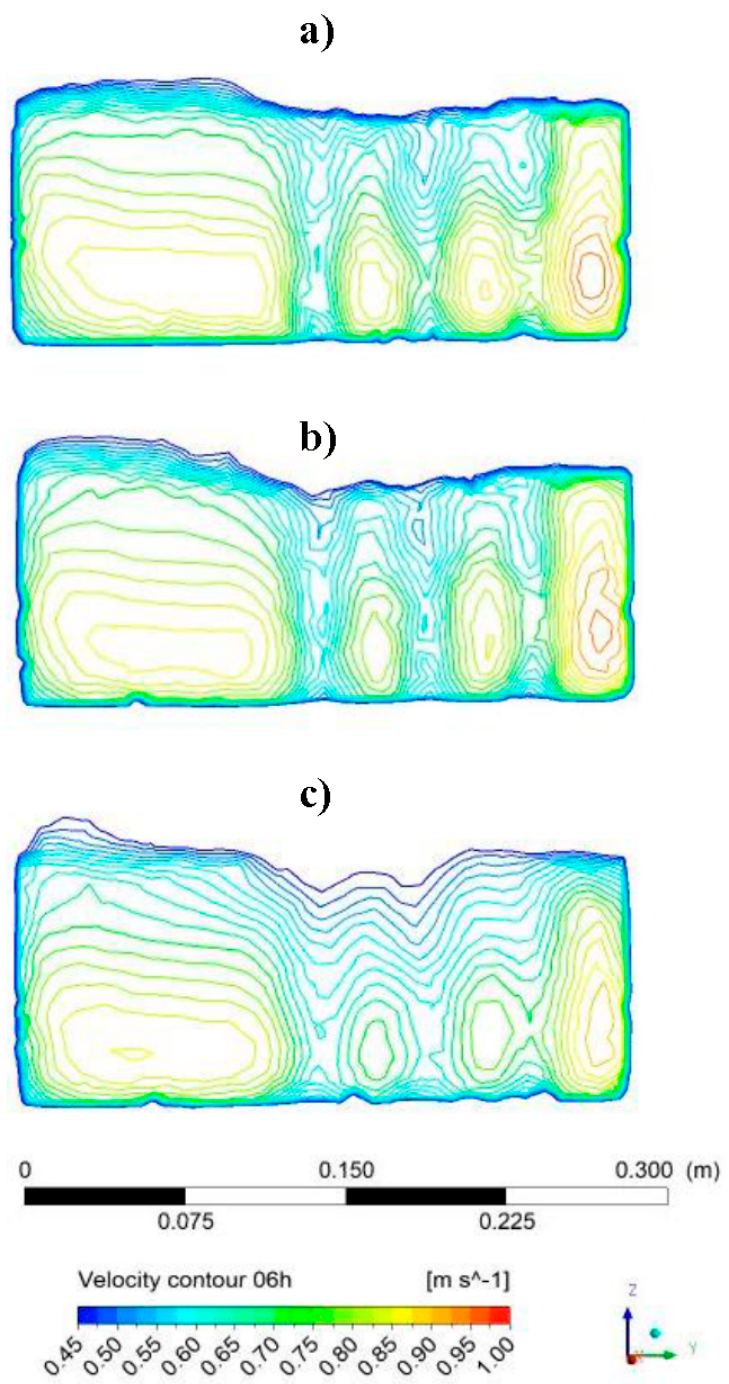
Figure 10. Velocity contours of ‘with vanes’ situation analysis ( a ) Section 1-1, ( b ) Section 2-2, ( c ) Section 3-3.